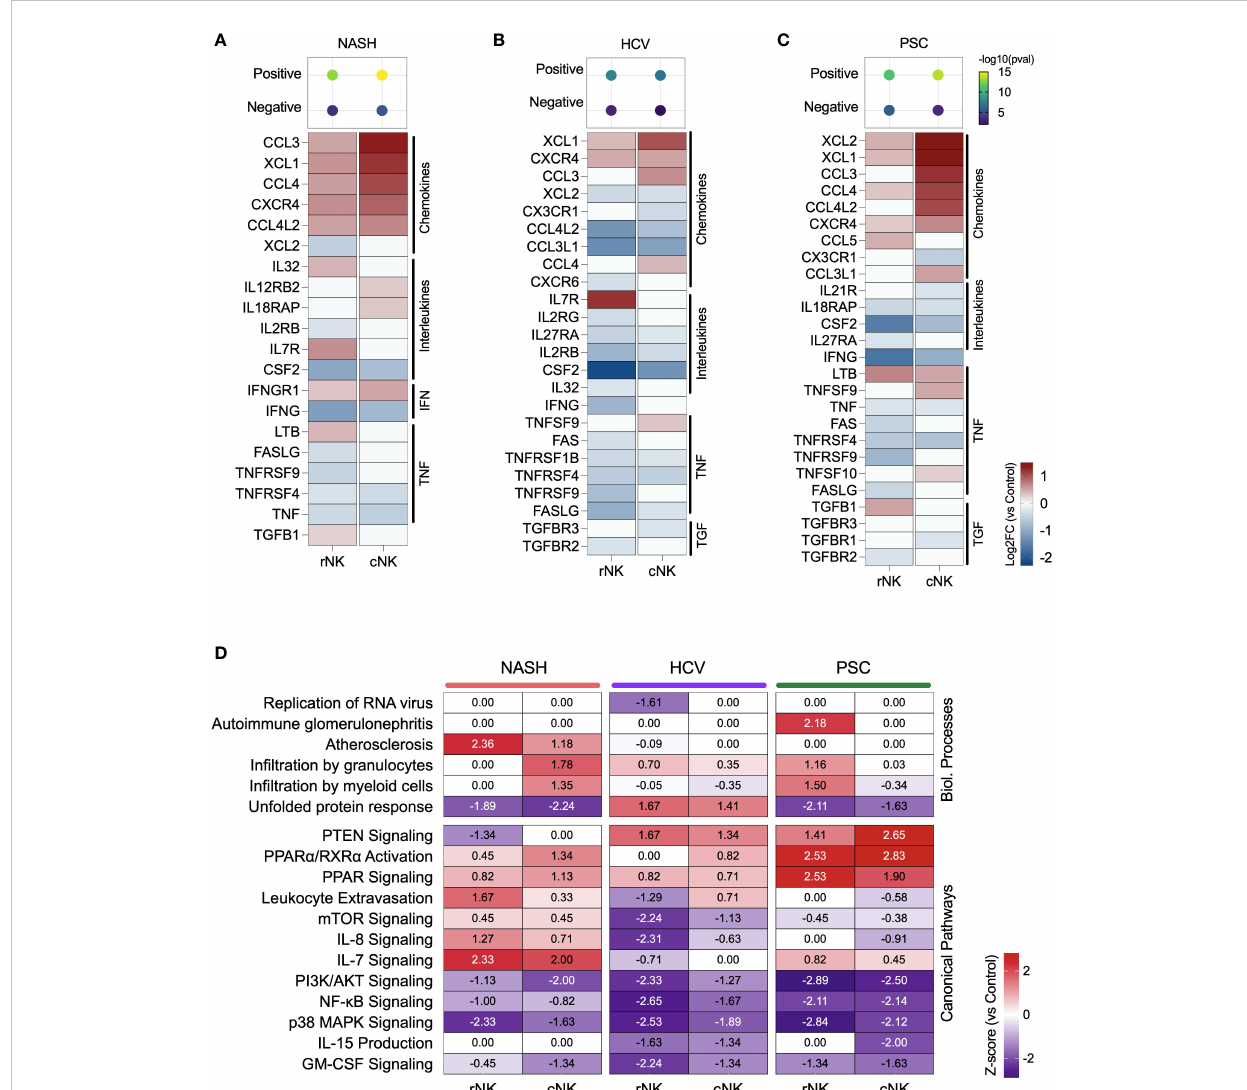
FIGURE 4 In fl ammatory activity of hepatic NK cells in end-stage liver diseases. (A – C) Top: enrichment scores for positive and negative regulation of cytokine production. Enrichment scores are scaled by -log10(pval). Bottom: fold changes (log2) of cytokines and their receptors expressed by NASH (A) , HCV (B) , and PSC (C) He-NKs compared to healthy He-NK cells. All values are expressed in the same scale and are statistically signi fi cant (Enrichment scores: -log10(pval) > 1.3; DEG: Log2FC > 0.27, FDR < 0.1). (D) Heatmap showing the most signi fi cant biological processes and canonical pathways related to in fl ammation and cytokines in He-NKs. Z-score values are included inside the